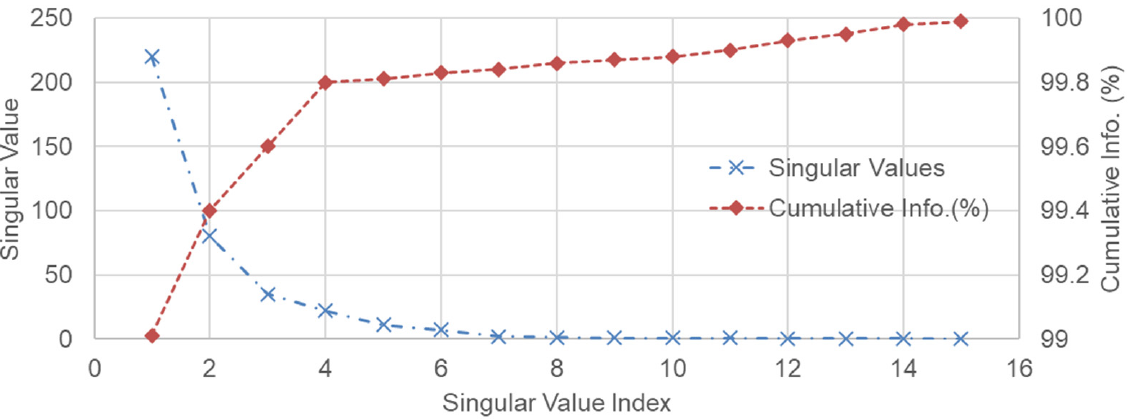
Figure 3. The variation in the singular value obtained by Equation (3) (left axis) and the cumulative information of the spectral (right axis).